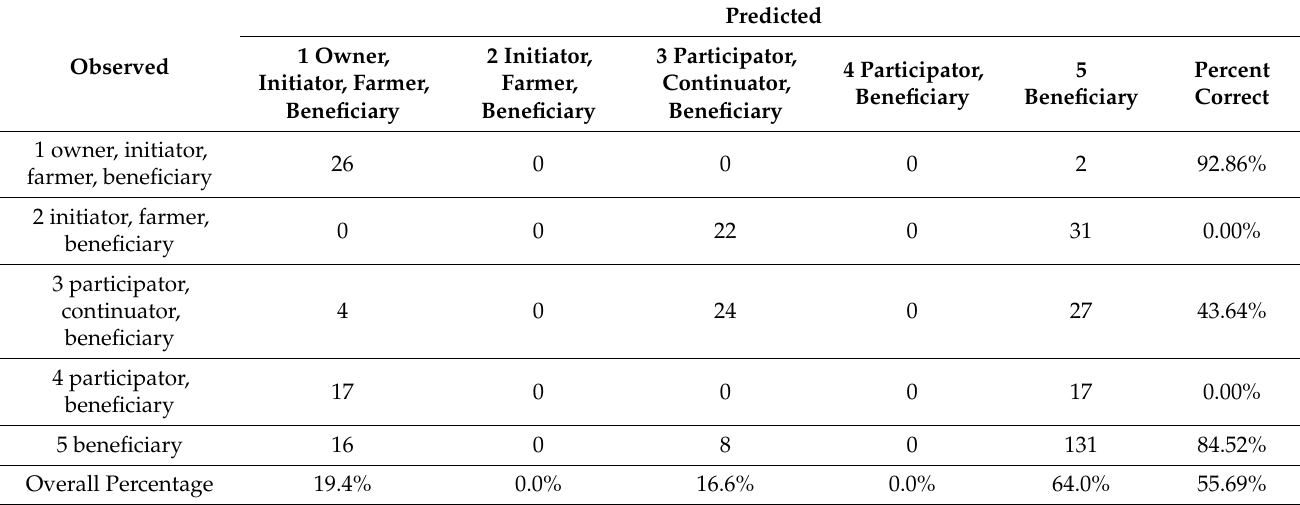
Table 6. Classification of decision tree